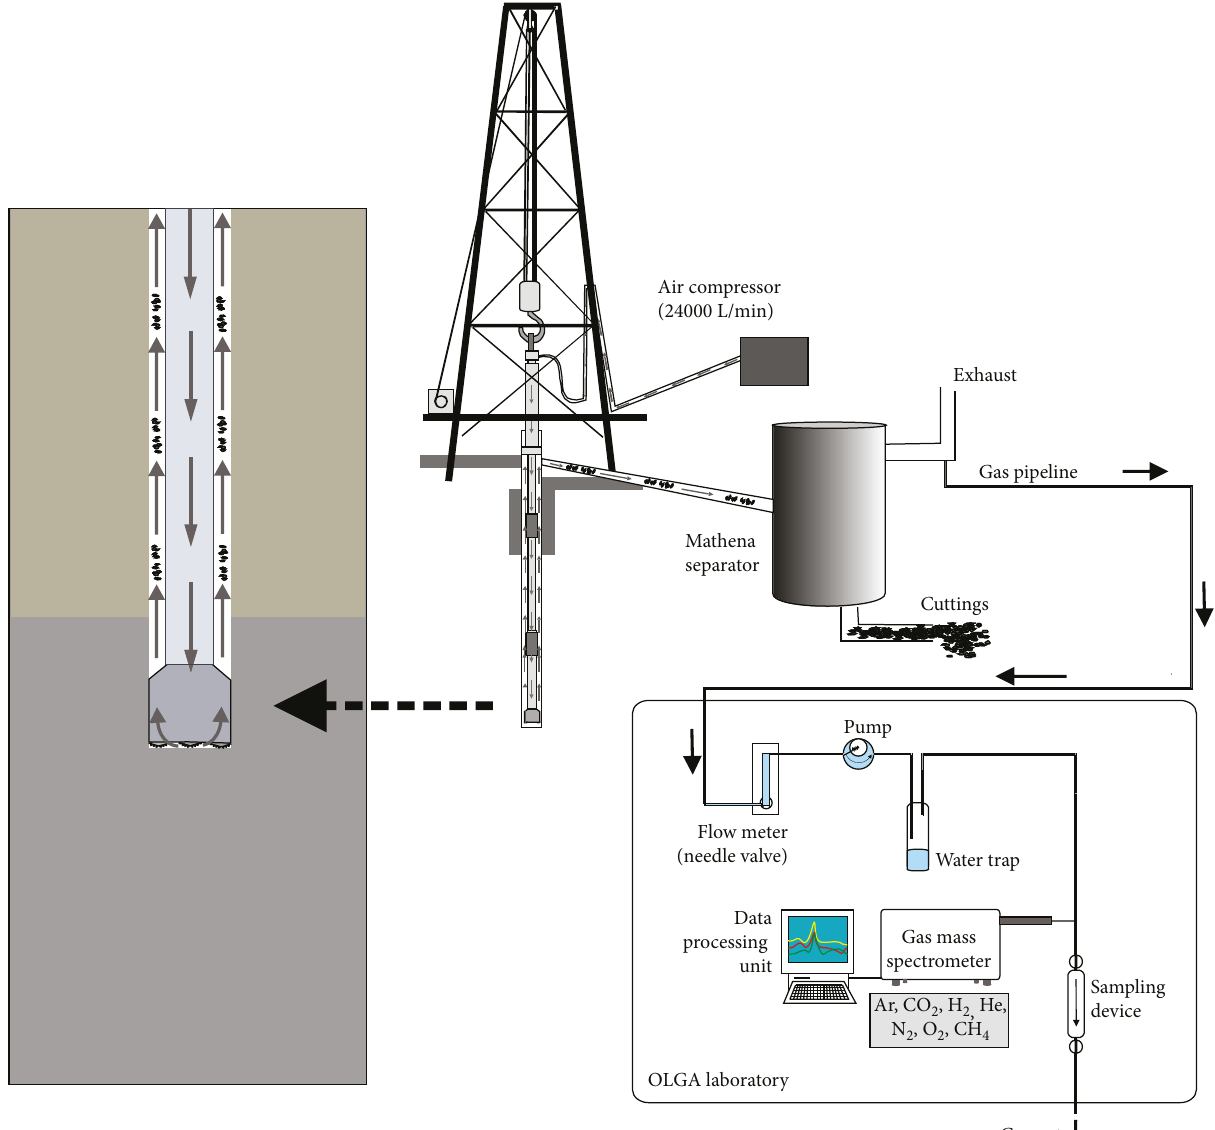
Figure 2: Schematic diagram showing the air hammer drilling setup and major components of the OLGA laboratory at the drill site. The Mathena shale gas separator is used to separate gas from borehole cuttings, and the gas is then pumped through a plastic tube to the nearby OLGA laboratory where the gases are